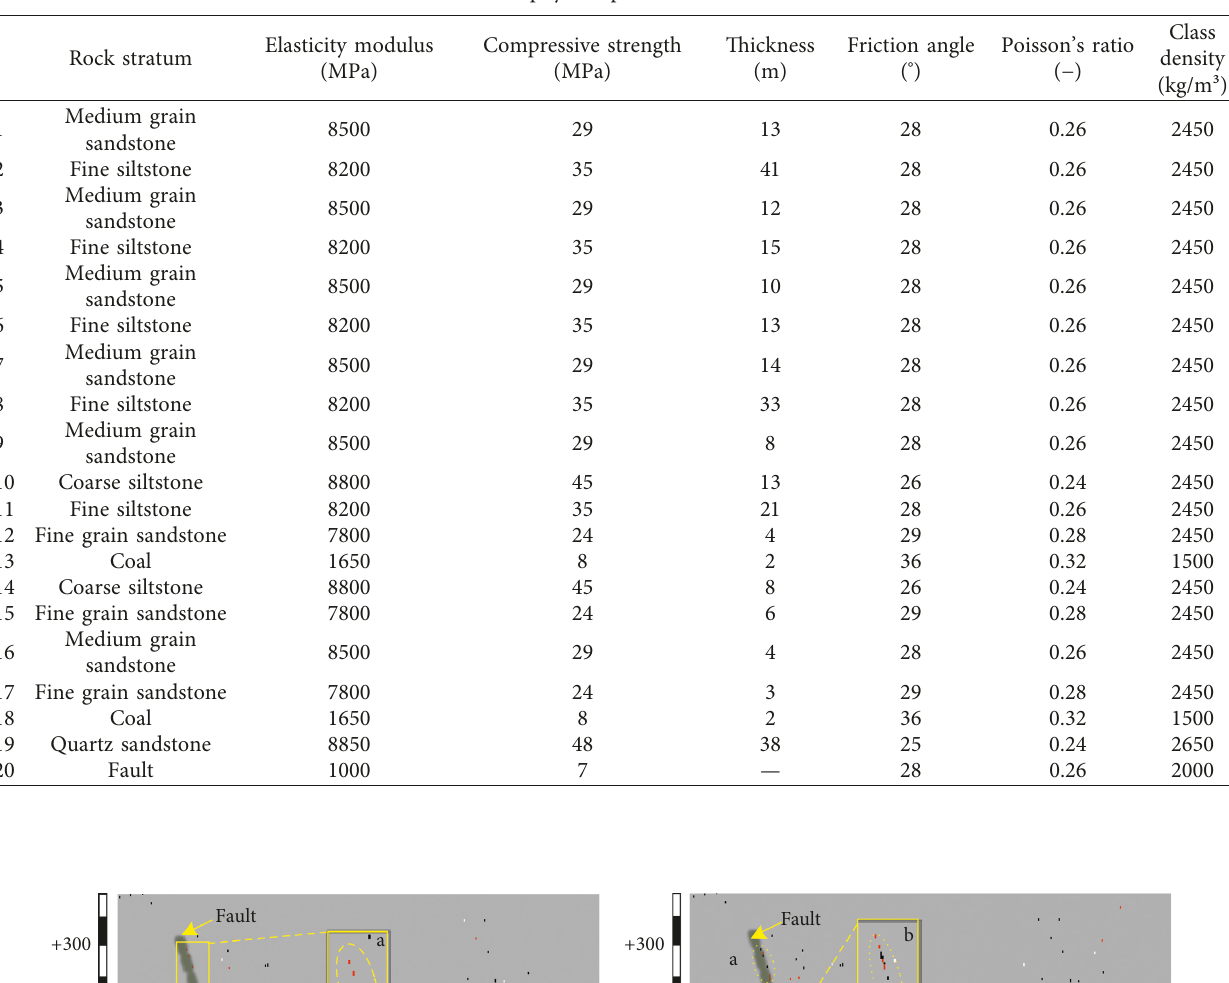
Table 2: The mechanics and physical parameter statistics of rocks in model.